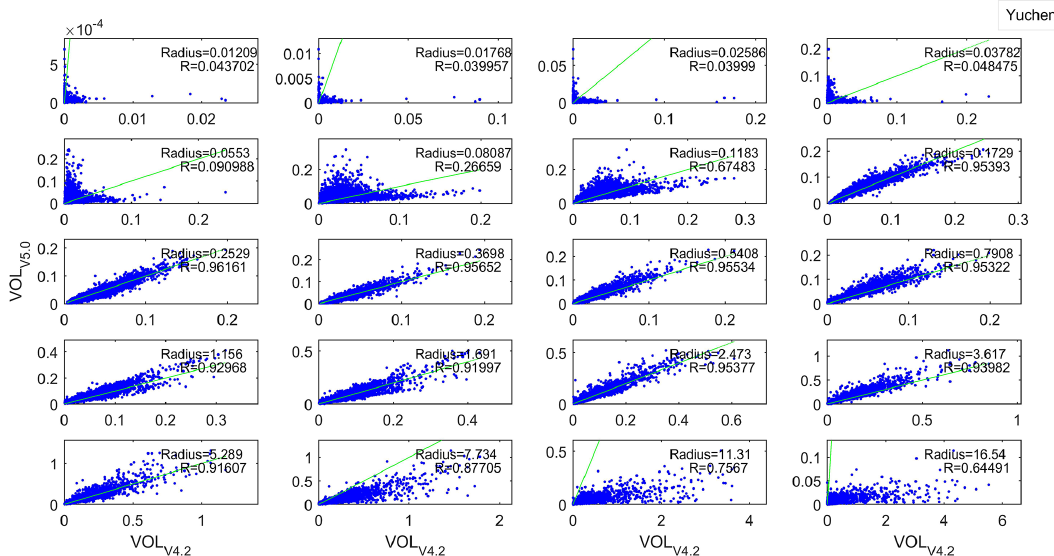
Figure 5. The same as Fig. 4 but for the Yucheng site.